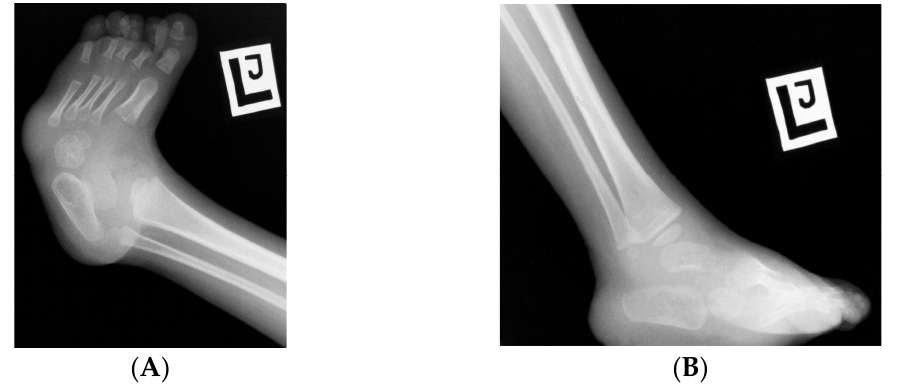
Figure 6. ( A , B ) Neurogenic clubfoot deformity. Partial sacral agenesis.